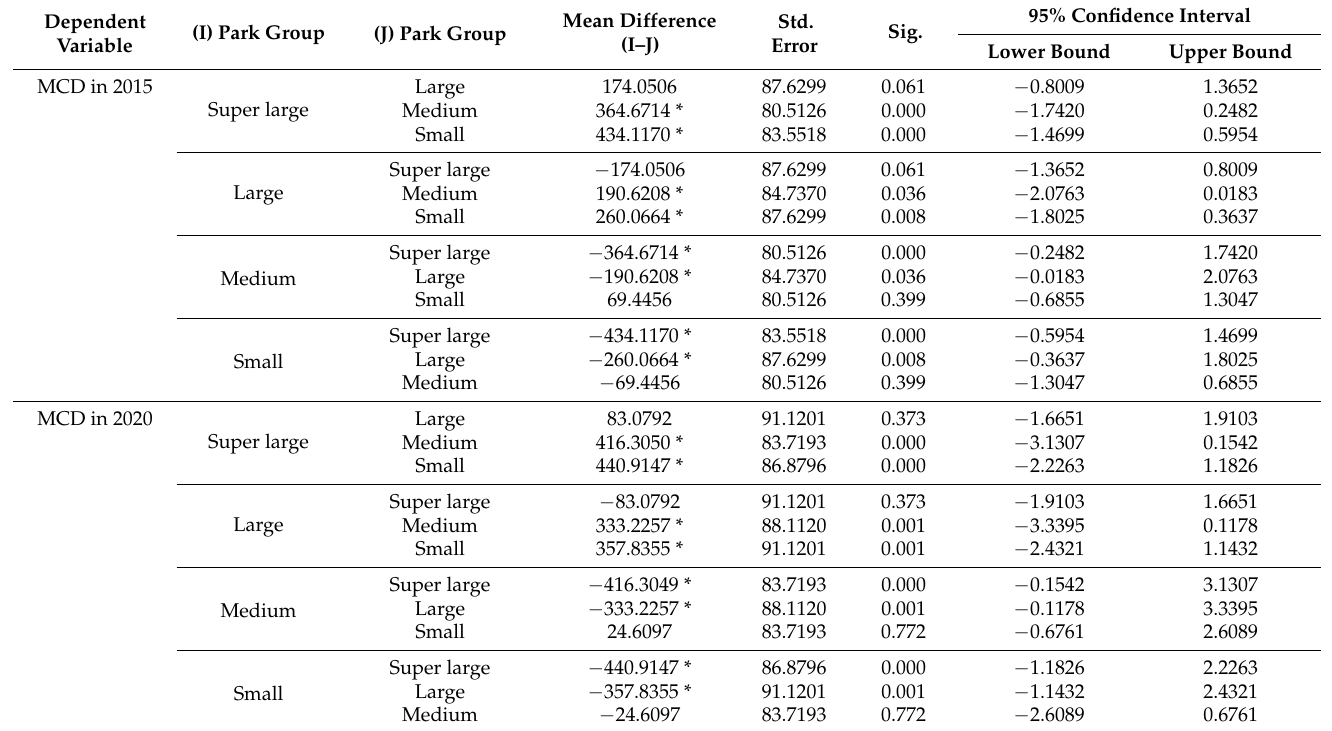
Table A1. Multiple Comparisons of MCD among park green spaces of different scales.